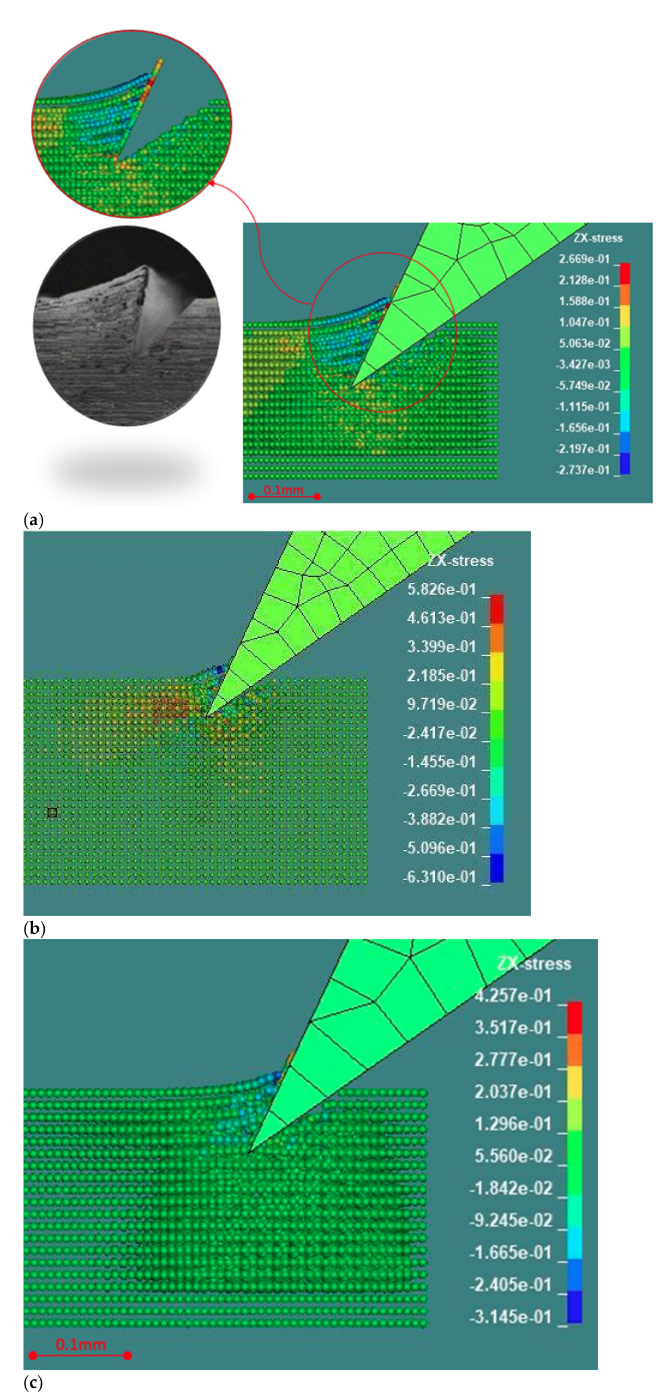
Figure 7. ( a ) LS-Dyna FEM simulation of Al 5083 H116 compared with machined Al 6060-T6 rescaled to conform the depths of cut (100 vs. 80 µ m). The phenomenological chip formation and quantitative deformation are consistent. A 2D video simulation is available in the Supplementary Material. ( b ) LS- Dyna FEM simulation of AISI 1040. Improvement over alternative processes in Figure 3 is foreseen regarding the smaller bottom radius. A 3D video simulation is available in the Supplementary Material. ( c ) LS-Dyna FEM simulation of Delrin POM-C. The phenomenological chip formation and quantitative deformation are consistent with Figure 4b after scaling to accommodate the different depths of